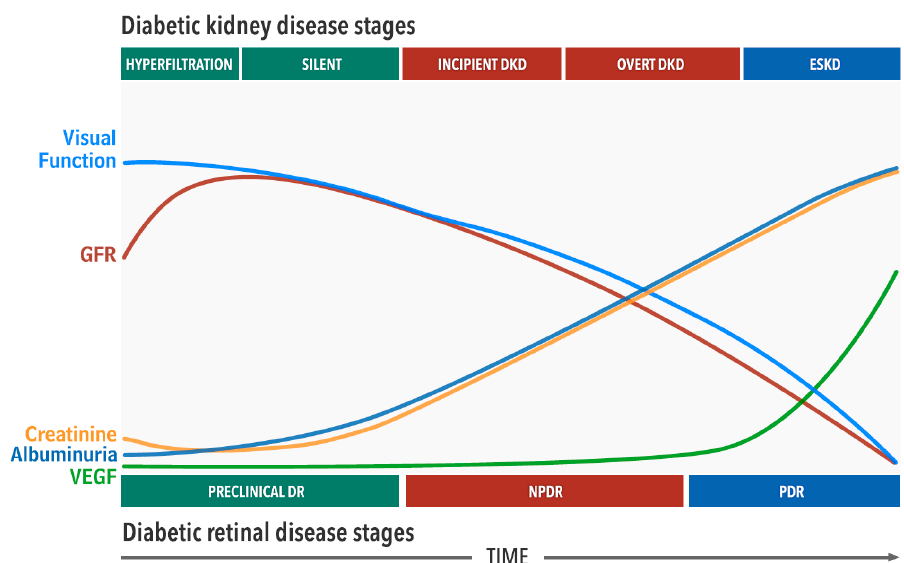
Figure 2. The parallel processes of diabetic kidney and retinal disease development and progression demonstrate an opportunity to identify early pathomechanisms of DRD. This figure illustrates a key aspect shared by DRD and DKD: As time progresses from onset of diabetes and adaptive measures have failed, progressive disease ensues (from left to right over time). DKD researchers have recently identified molecular pathways active in early DKD (green bars, top left of chart) that are associated with increased risk for disease progression before classic markers such as albuminuria, serum creatinine, or GFR are affected. By striving to characterize better the molecular pathways active in the analogous preclinical period of DRD (green bar, bottom left of chart) that are associated with progression before VEGF has a central role and visual function is impaired, targeted therapies halting or reversing early disease may become possible. The stages of DKD (top row) progress from the hyperfiltration stage to the silent, incipient, overt DKD stages and ultimately to end-stage kidney disease (ESKD). The stages of DRD (bottom row) progress from preclinical diabetic retinopathy to non-proliferative DR, to proliferative DR. Biomarkers including albuminuria (navy line), creatinine (yellow line), and VEGF (green line) help diagnose the stage of the disease and determine the estimated kidney function by GFR (red line). Similarly, a hypothetical visual function (blue line) could potentially be estimated. GFR: Glomerular filtration rate, VEGF: Vascular endothelial growth factor, DR: Diabetic retinopathy, NPDR: Non-proliferative diabetic retinopathy, PDR: Proliferative diabetic retinopathy.